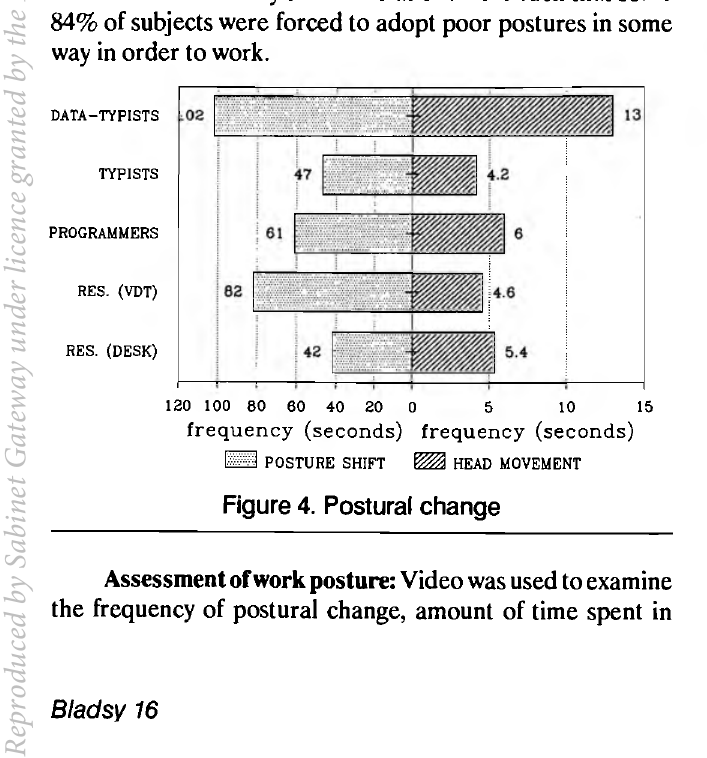
Figure 5. Duration of postures (group median body